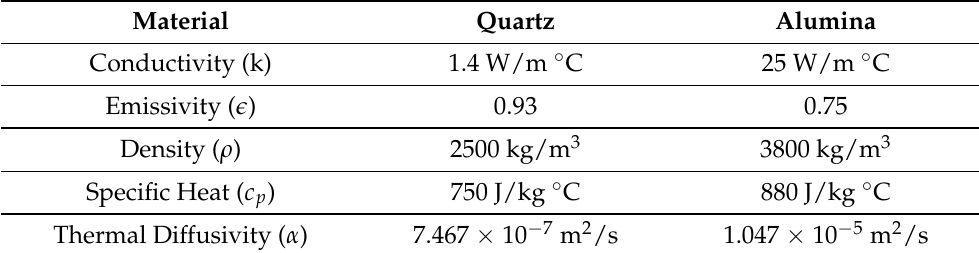
Table 1. Thermal properties of quartz and